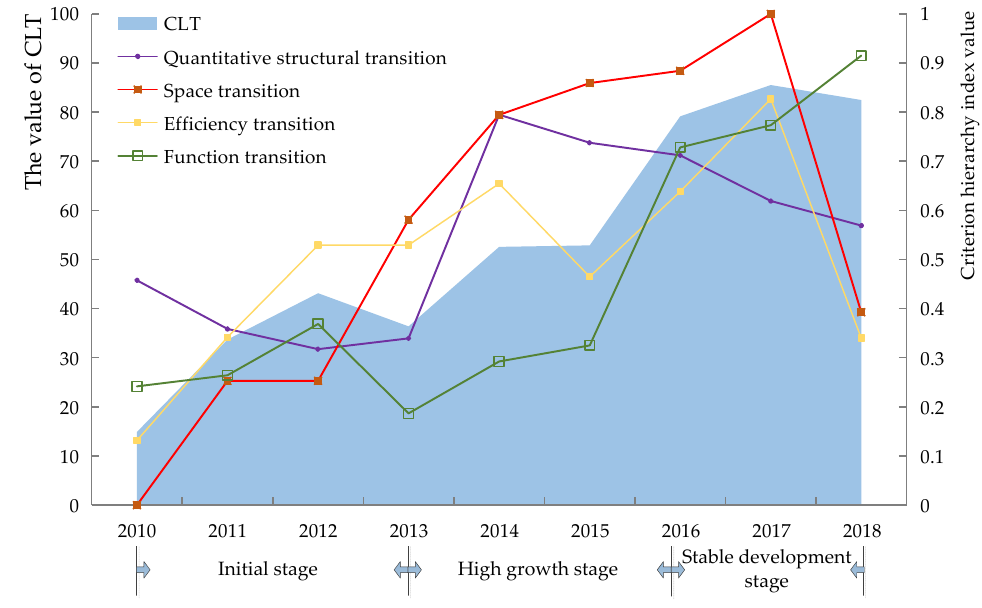
Figure 7. Level of CLT in Linqing County from 2010 to 2018.